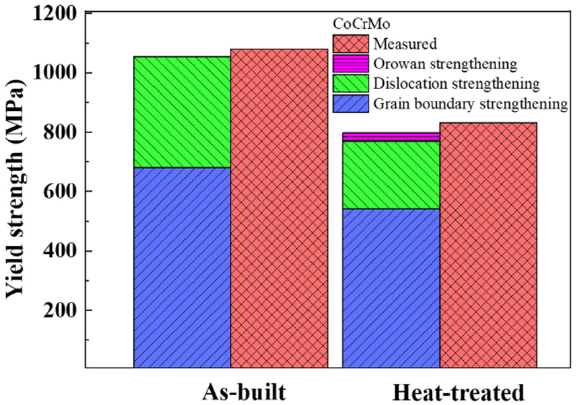
Figure 11. The measured and calculated yield strengths consisting of the grain boundary strengthen- ing, dislocation strengthening, and Orowan strengthening in the fully dense as-built and heat-treated CoCrMo alloys.